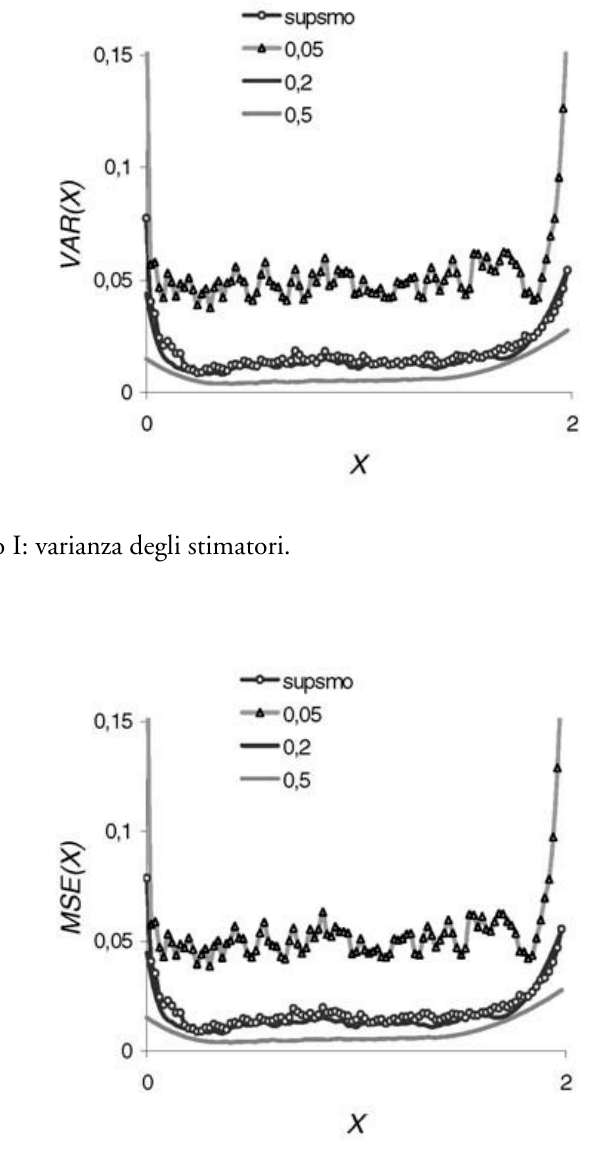
Figura 4 – Modello I: errore quadratico medio degli